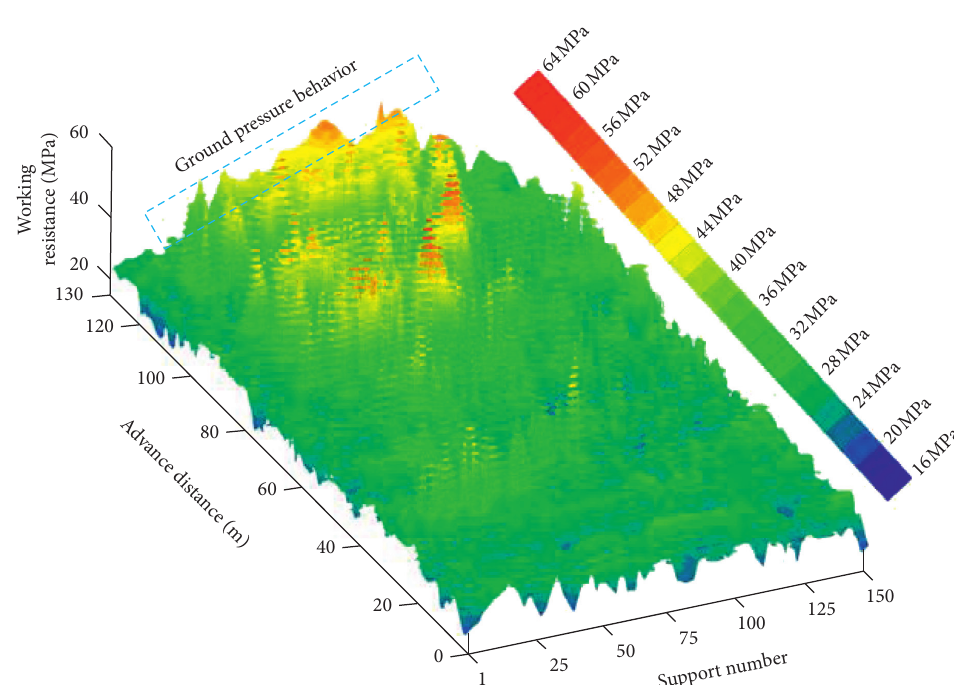
Figure 2: Morphology of borehole walls at different